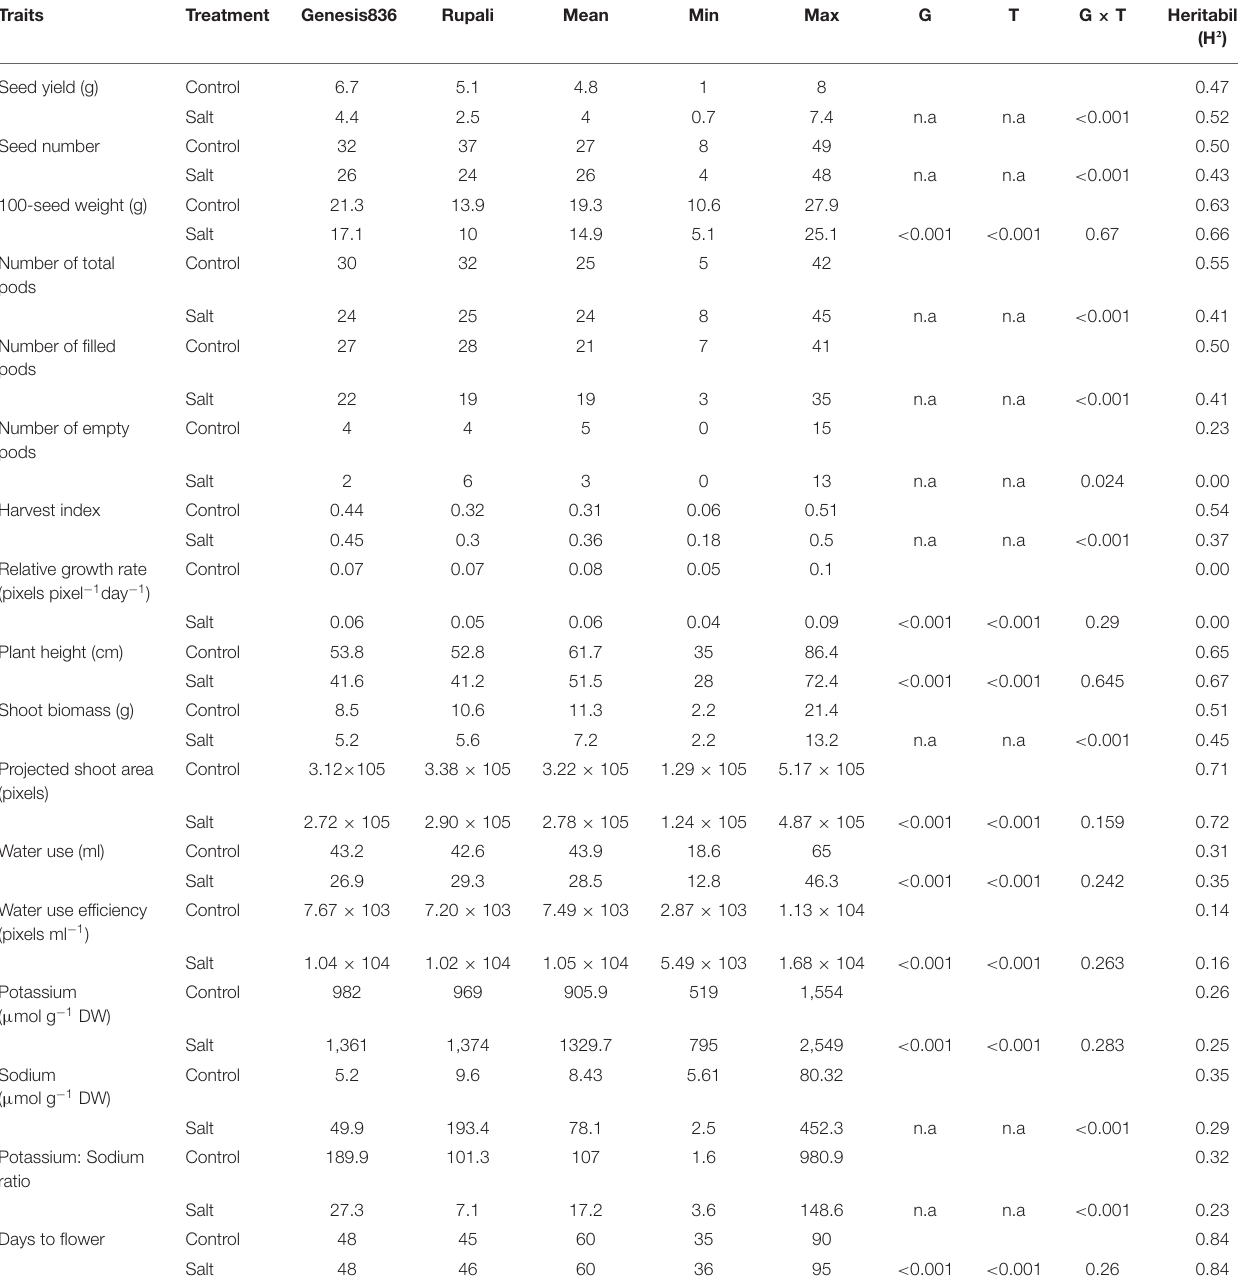
TABLE 1 | Summary of measurements taken in the glasshouse under salt and control conditions.